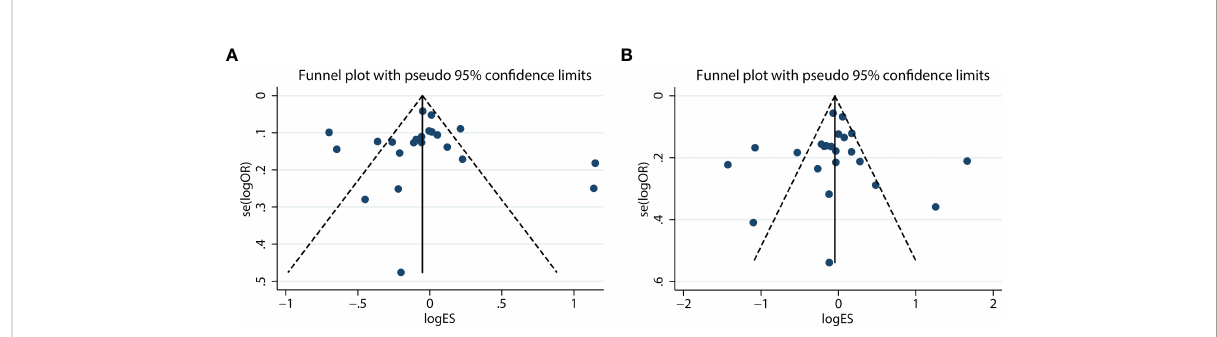
FIGURE 4 Funnel plot of the allelic (G vs. C) (A) and dominant (CG + GG vs. CC) (B) models for the resistin (RETN) -420C/G polymorphism and type 2 diabetes mellitus (T2DM)